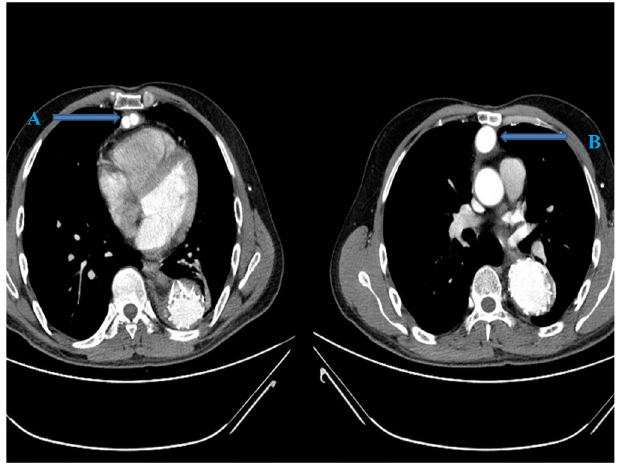
Fig. 6 – Follow-up computerized tomography angiography image at the first year. A) Distal legs of Y-graft are anastomosed to celiac and superior mesenteric arteries; B) proximal segment of Y-graft anastomosed to ascending aorta.